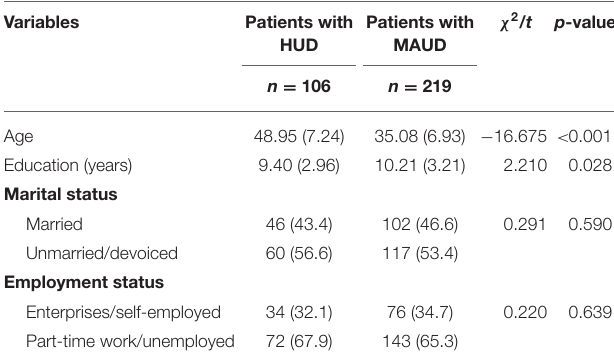
TABLE 1 | Demographic information of patients with HUD and patients with